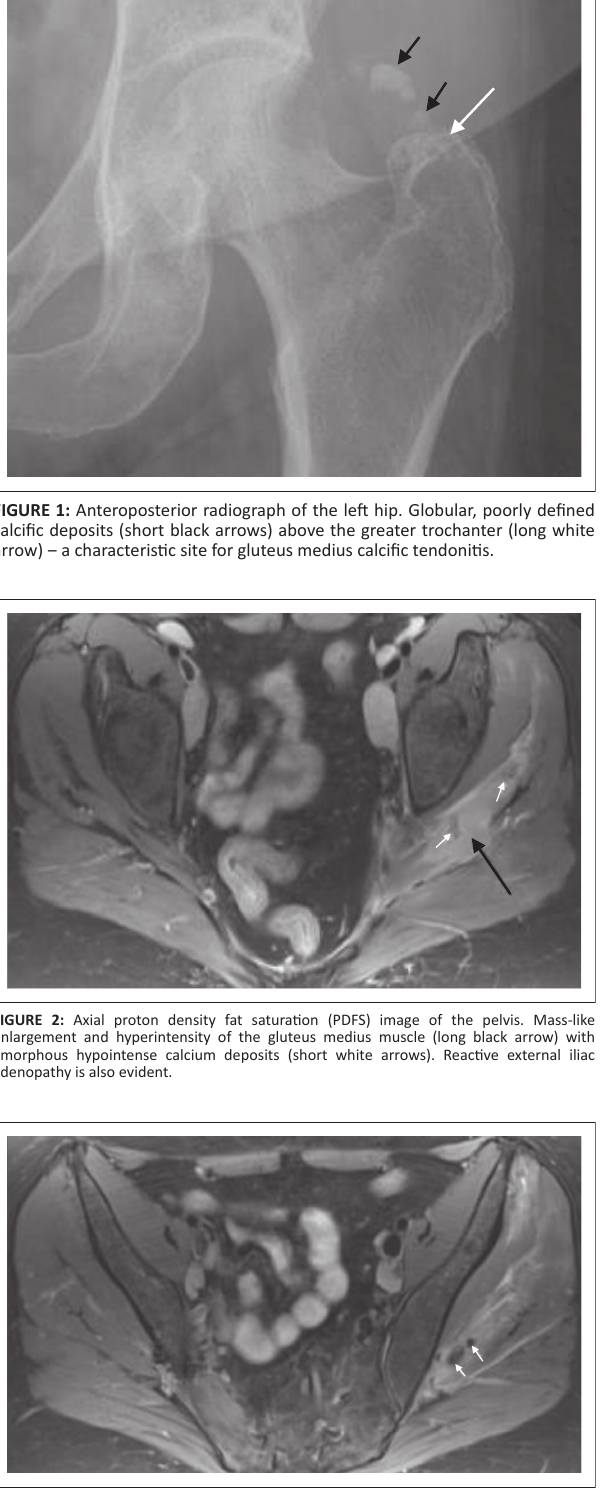
FIGURE 3: Axial proton density fat saturation (PDFS) image of the pelvis. Defined globular calcium deposits are evident.